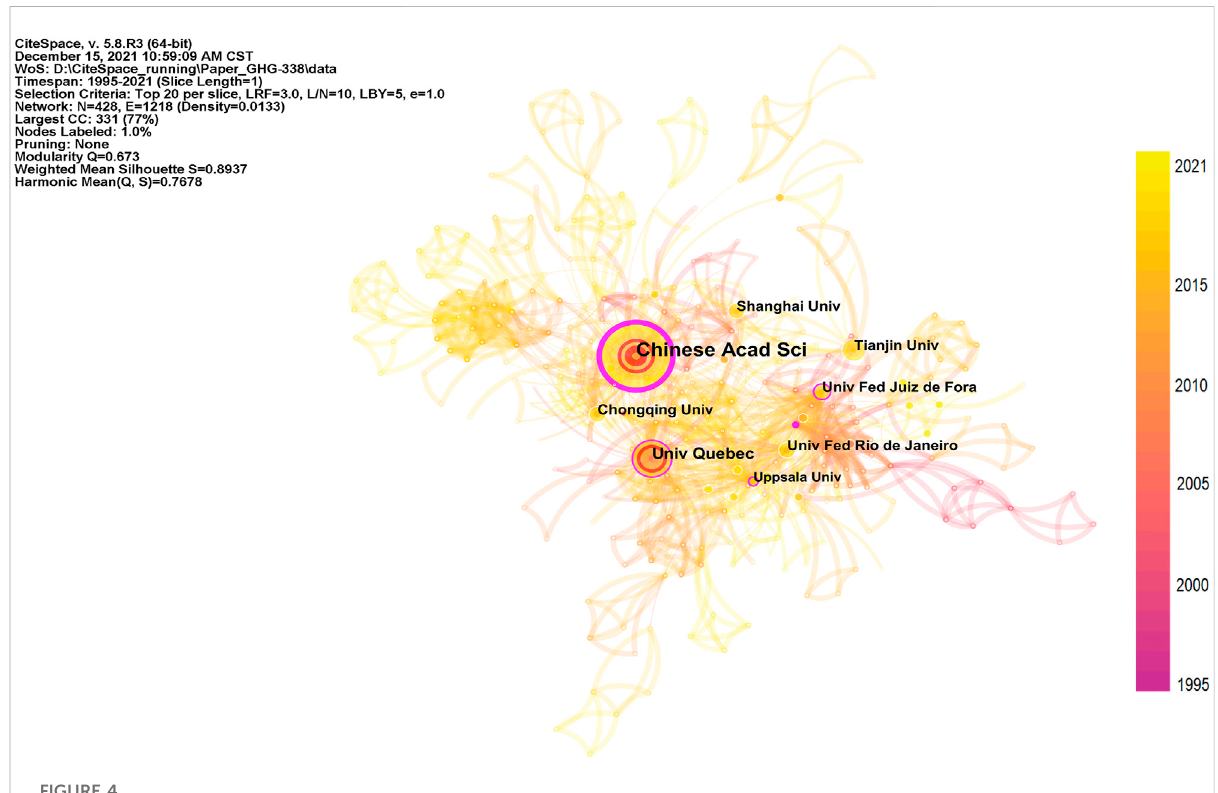
FIGURE 4 Cooperation network among institutions in GHG-HR research fi eld.